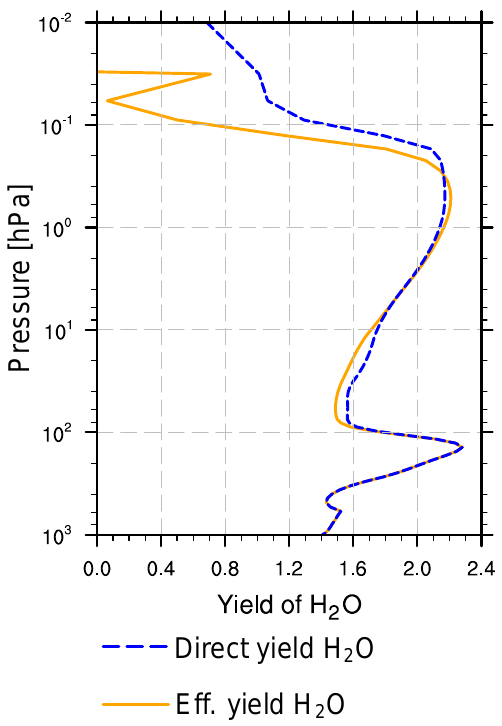
Figure 10. Effective and direct yield calculated from results of the global simulation in the tropics (23 ◦ S–23 ◦